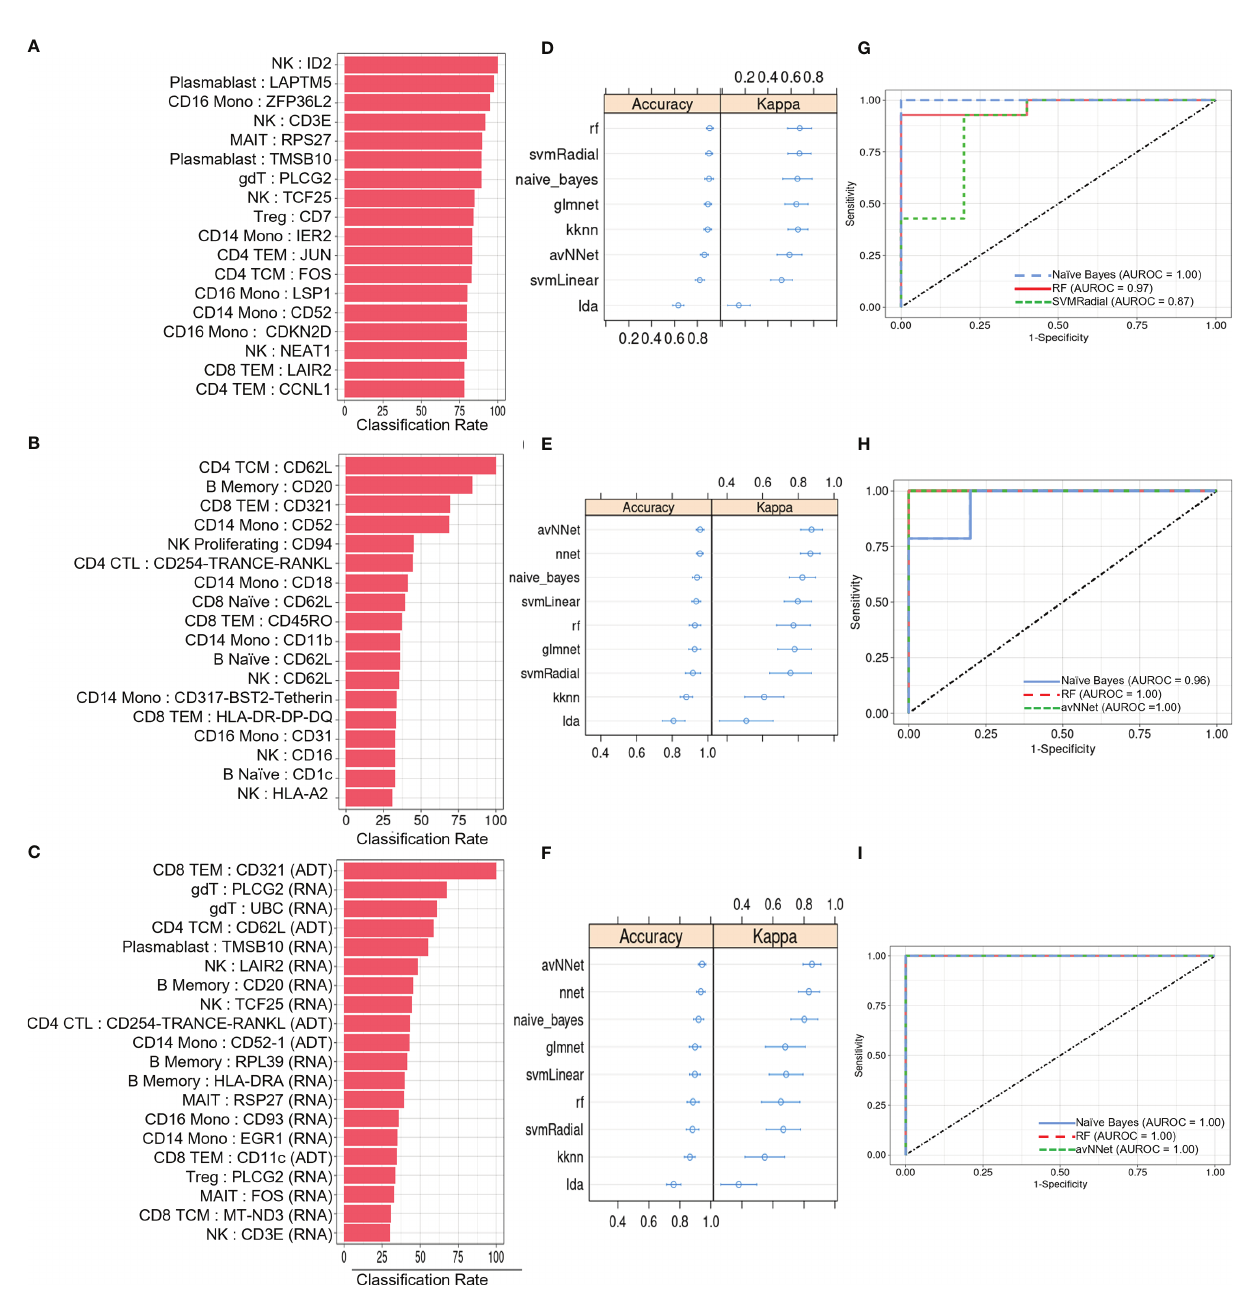
FIGURE 4 | ML classi fi cation of AS and healthy subjects. Classi fi cation rate of (A) top 18 DEGs, (B) top 18 DEPs, and (C) top 20 features from the set of combined DEGs and DEPs from ensemble feature selection, along with their respective (D – F) prediction accuracy and kappa using 9 ML models and (G – I) ROC curves based on test set classi fi cation. Error bars indicate 95% con fi dence